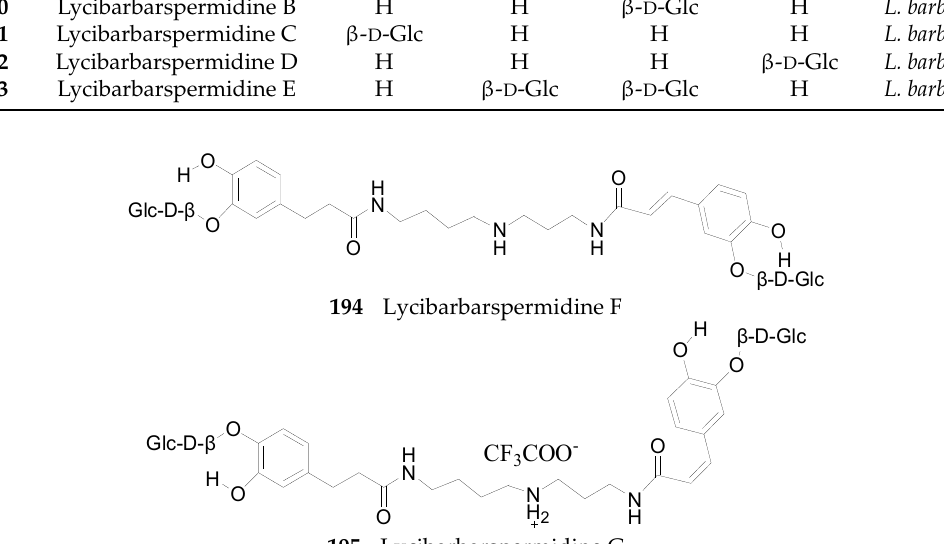
Figure 14. Chemical structures of compounds 194 and 195 . Table 10. Chemical structures of compounds 196 – 200 .